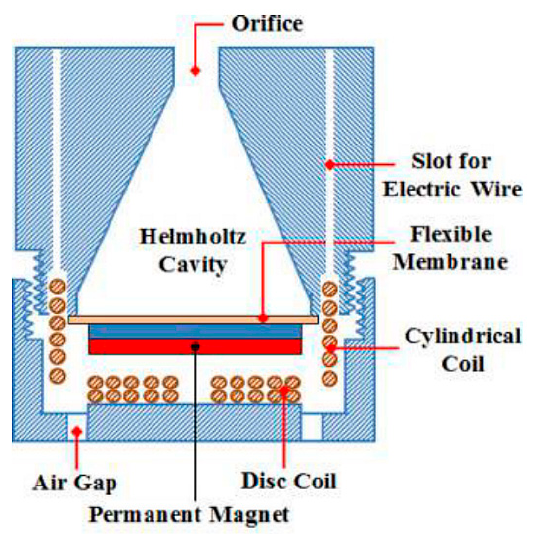
Figure 10. Schematic diagram of the proposed AEH, which is equipped with a conical Helmholtz resonator and an electromagnetic conversion device. Reproduced with permission from [41]; published by Emerald Insight, 2018.